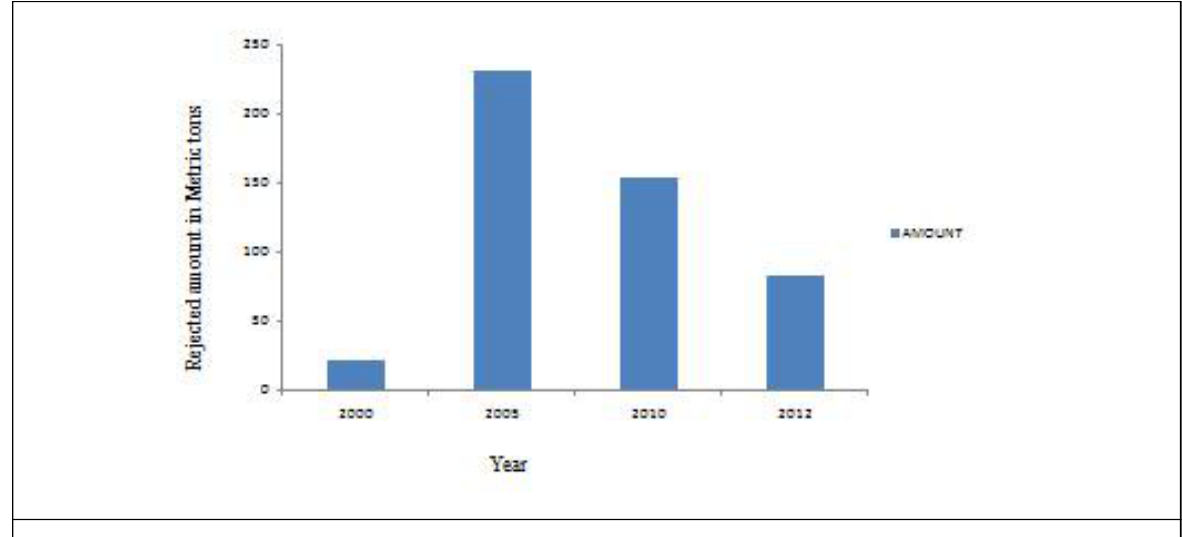
Figure 4: EU’s rejection of herb and spice products (selected years) Source: Authors’ compilation from Rapid Alert System for Food Feed (RASFF) and United Nations Industrial Development